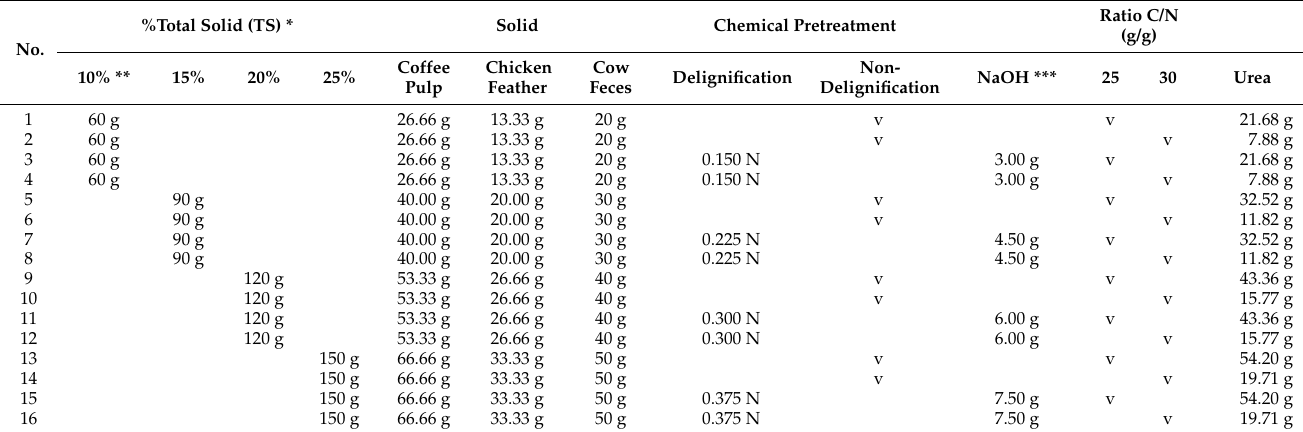
Table 1. Variable